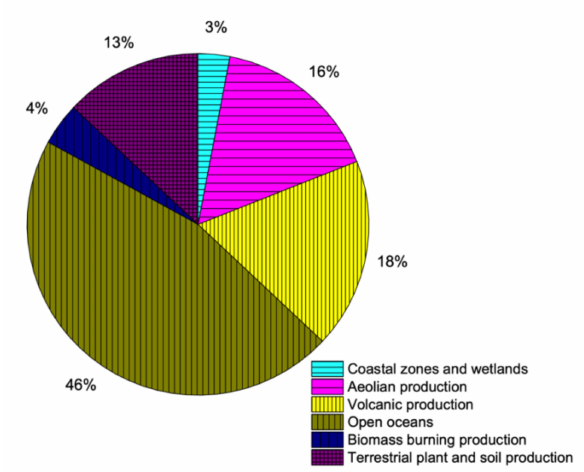
Figure 2. Contribution of sulfur through natural resources (data extracted from Reference